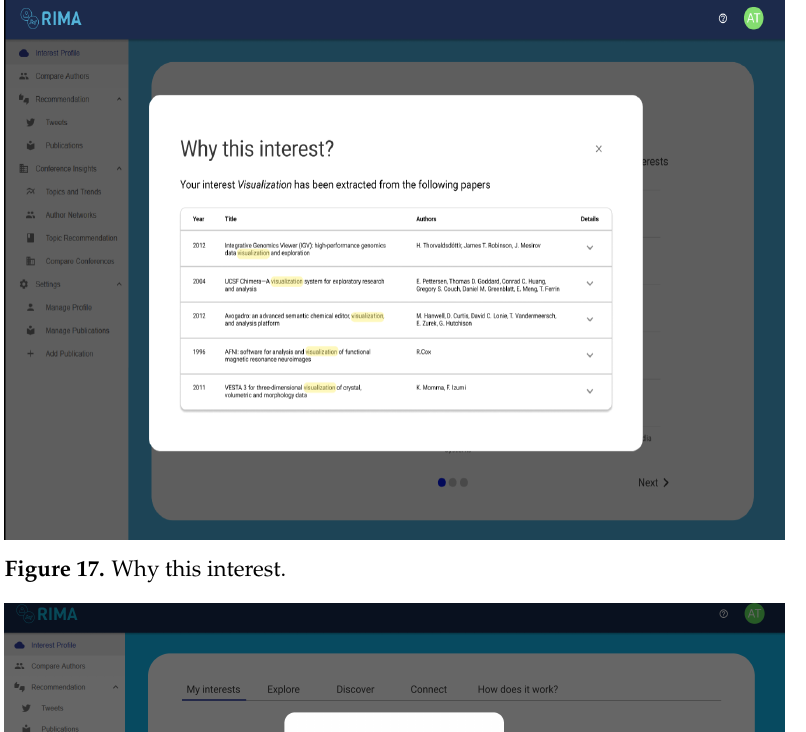
Figure 17. Why this interest.